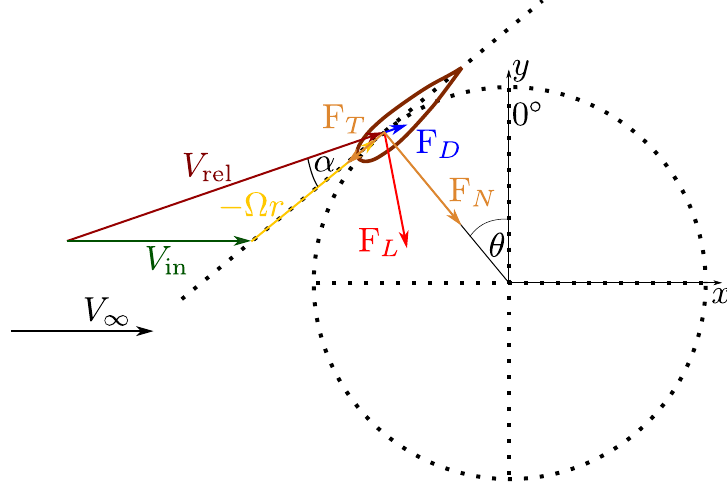
Figure 1. Illustration of velocity vectors and forces acting at the cross-section airfoil